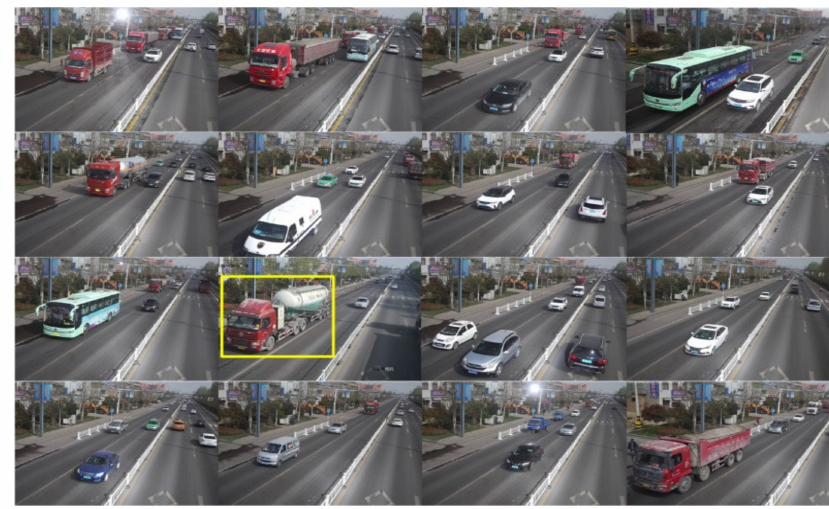
Figure 6. A sample of some of the images in the training dataset.